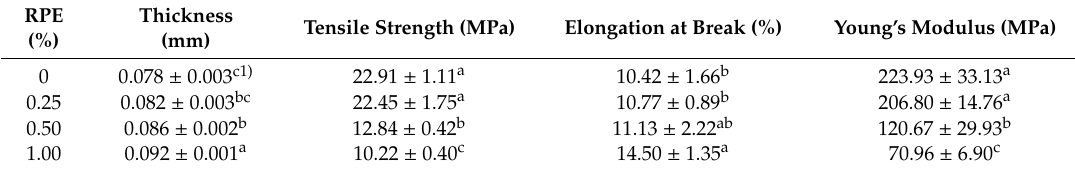
Table 2. Mechanical properties of the CJP films containing di ff erent concentrations of